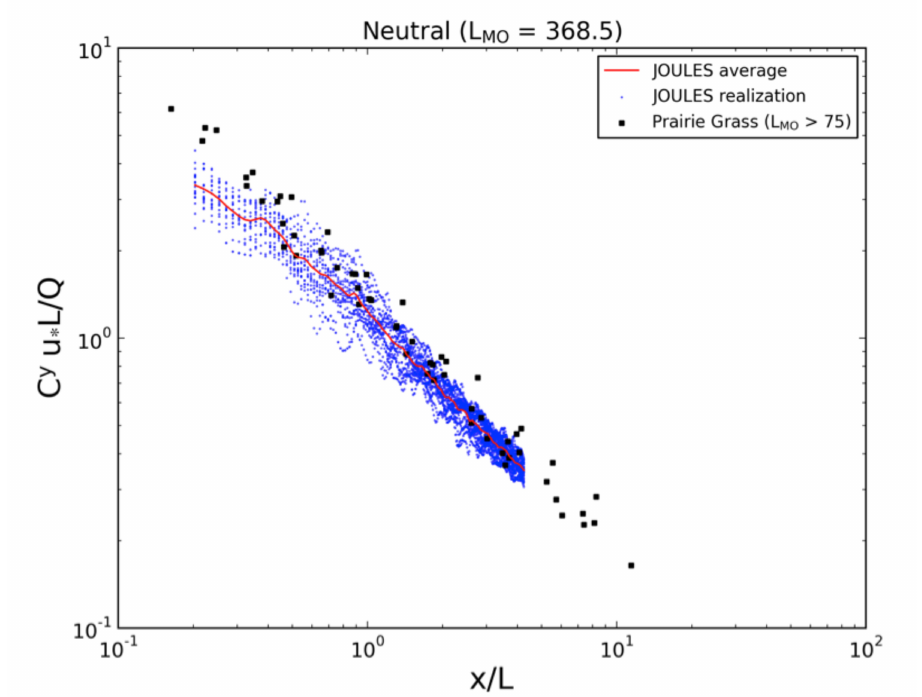
Figure 11. Normalized crosswind integrated concentration as a function of the downwind distance from the release location, for neutral stability conditions. The blue dots represent individual realizations of dispersion from the GPU-LES model, where the simulation was designed to produce neutral conditions with L = ~368. The red line represents the average of this ensemble. The black squares represent observations from the Prairie Grass experiment during neutral